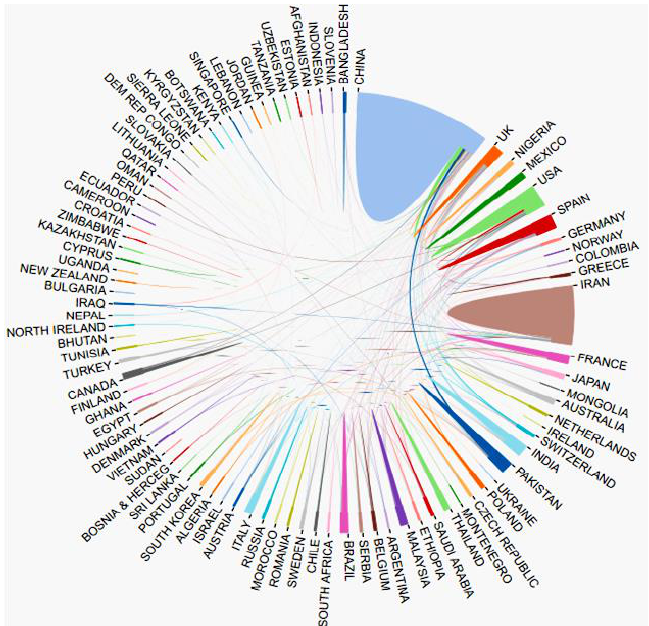
Figure 4. Cooperation between countries.